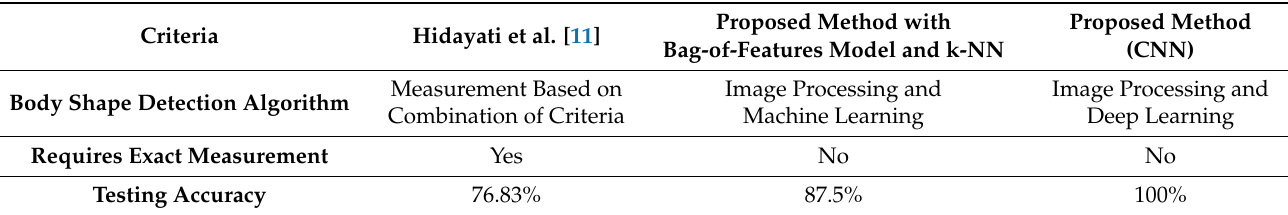
Proposed Method (CNN) Image Processing and Deep Learning